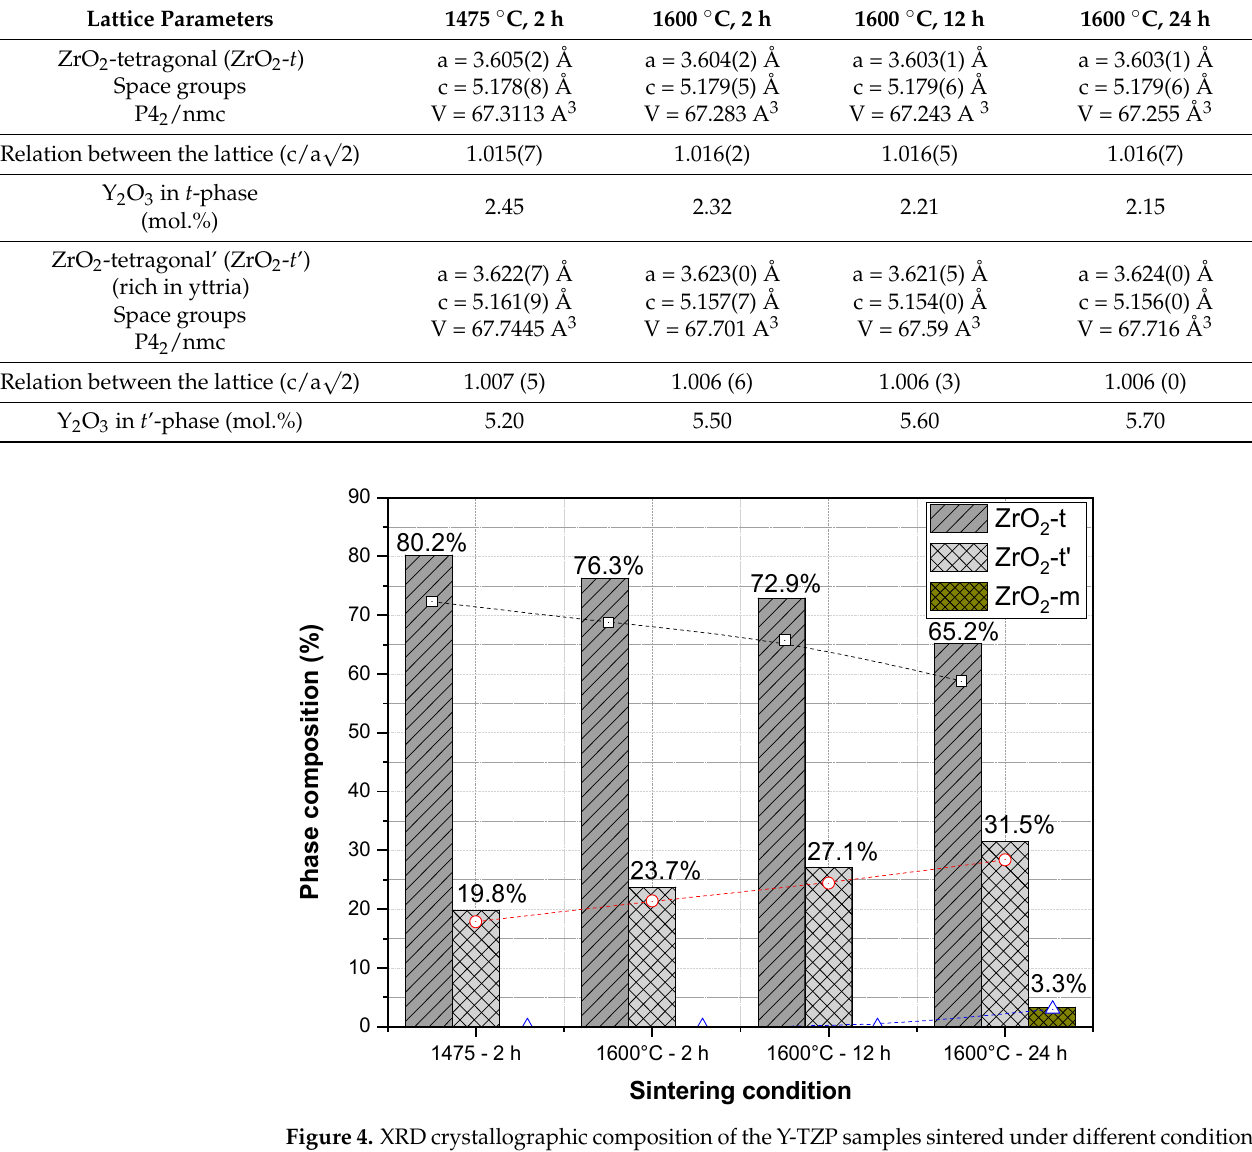
Table 1. Refinement of 3Y-TZP crystal structure after sintering at different temperatures.